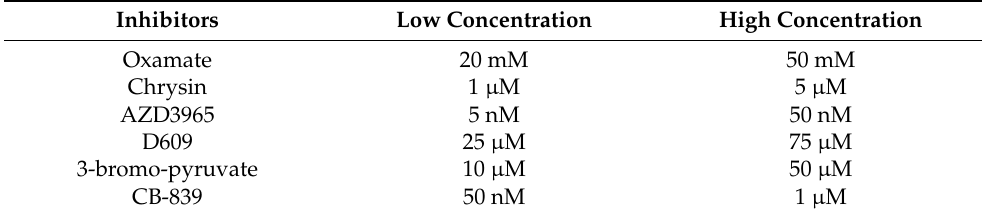
Table 1. Concentrations of the metabolic inhibitors.